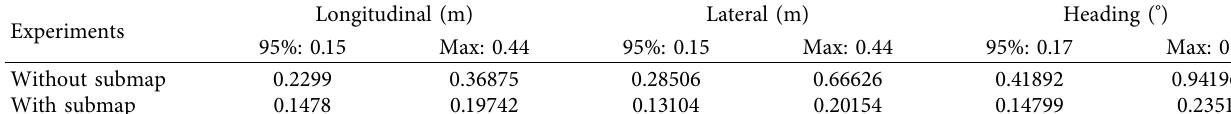
Table 4: Table of robust localization performance in experiments.